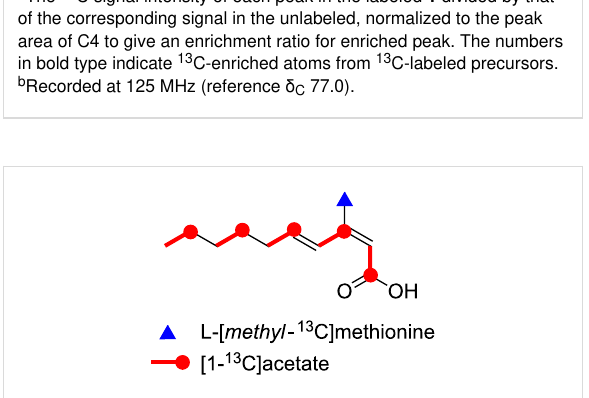
Figure 4: Incorporation of 13 C-labeled precursors into 1